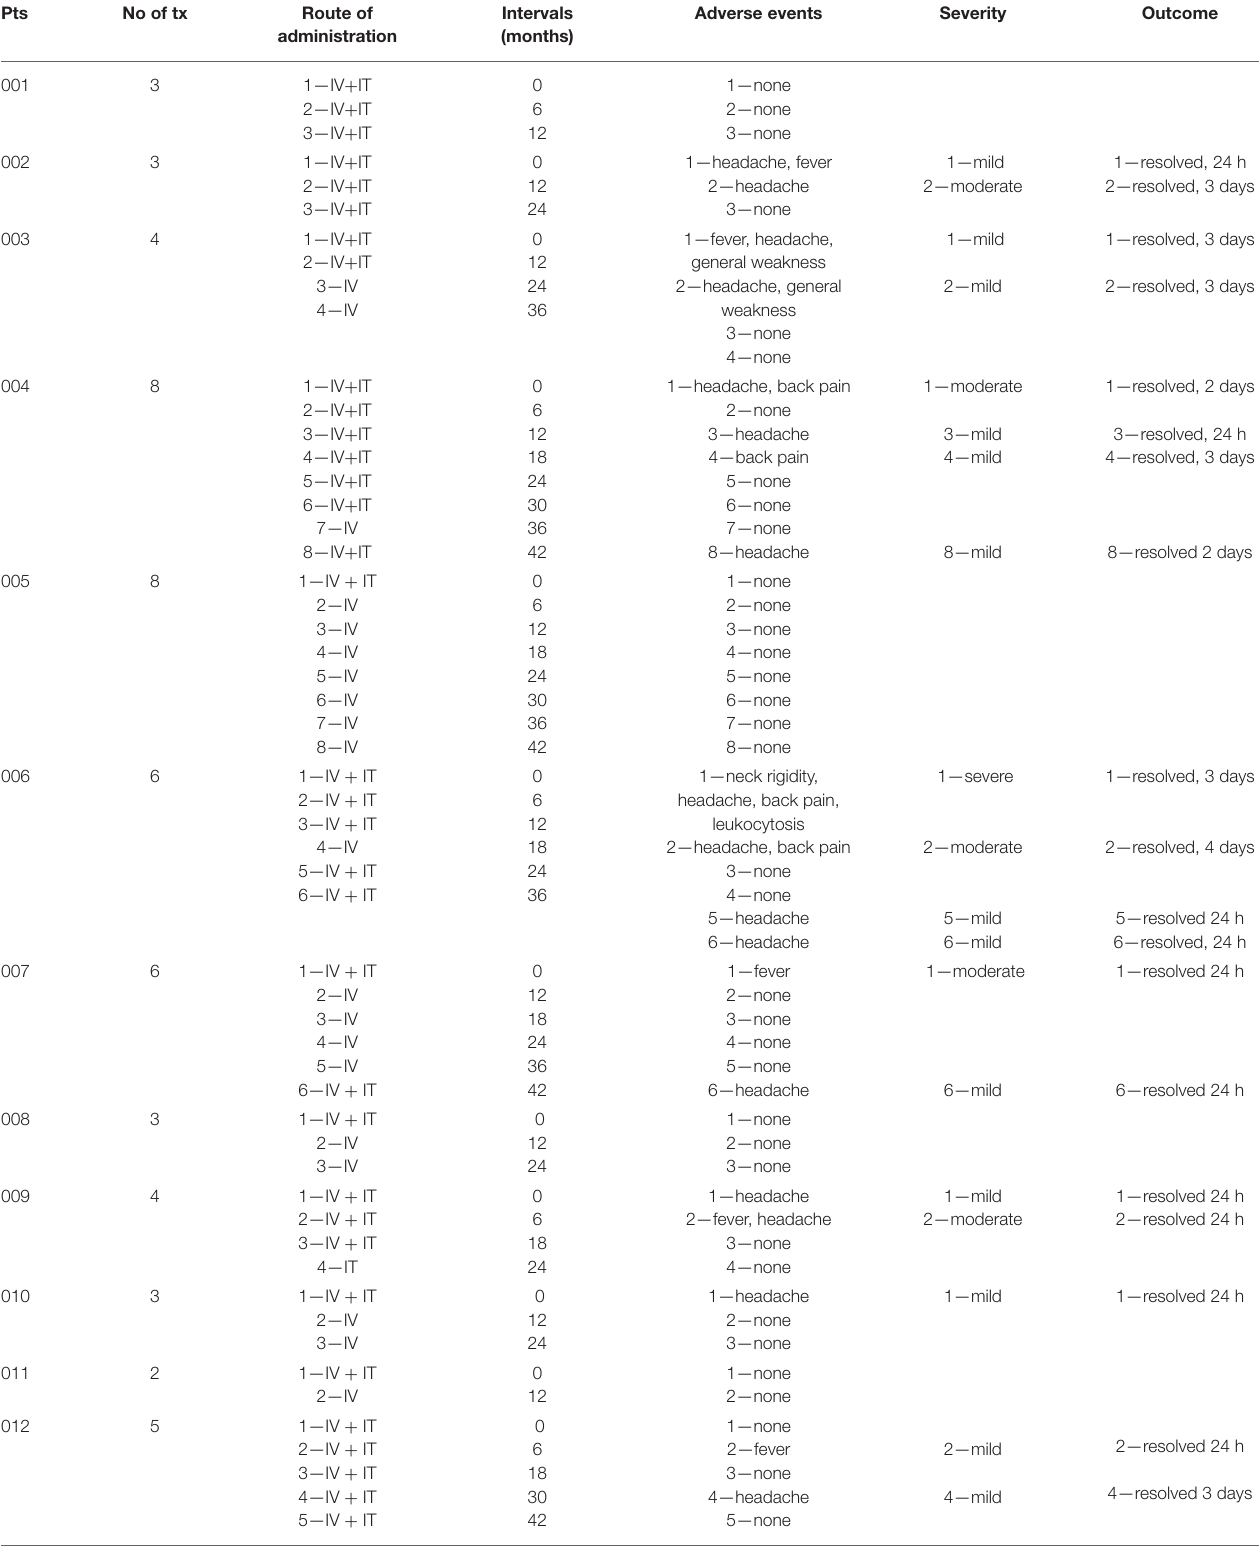
TABLE 2 | Safety (adverse